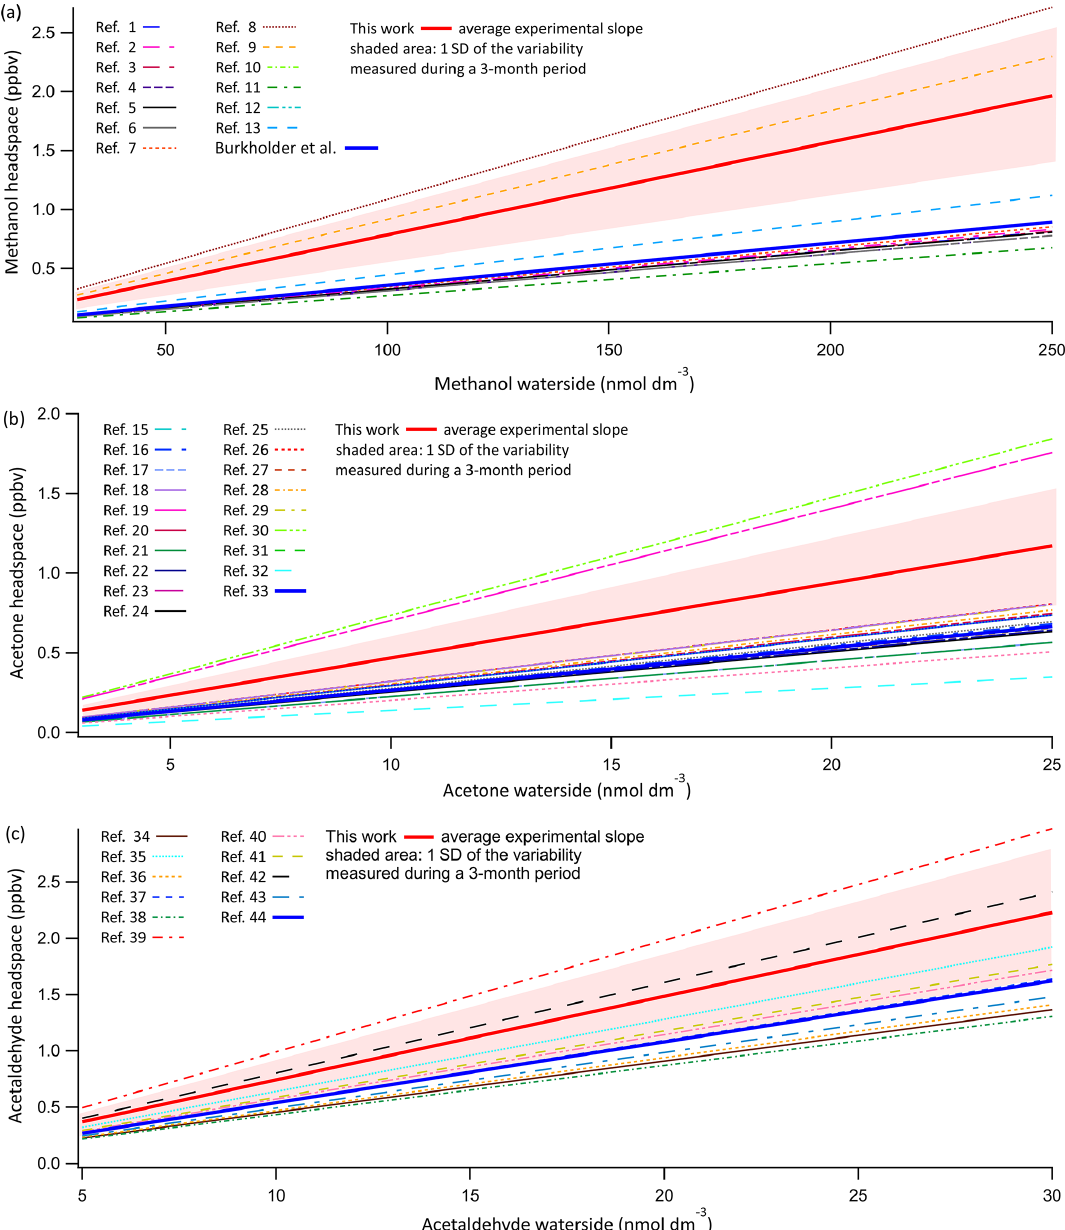
Figure 4. Evasion calibrations of OVOCs. Displayed are the average experimentally determined slopes of 14 calibration curves of methanol (a) and acetone (b) and 11 calibration curves of acetaldehyde (c) . These calibrations suggest possibly lower solubility of these com- pounds compared to literature values. Shaded area indicates 1 σ standard deviation of the variance in the slope during this 3-month period. Average experimentally determined calibration slopes for methanol, acetone, and acetaldehyde were 0 . 00786 ± 0 . 00115, 0 . 0469 ± 0 . 0145, and 0 . 0743 ± 0 . 0190ppbvnmol − 1 dm 3 . Plotted along this are the predicted slopes using all experimentally determined solubilities as listed in Sander (2015). The recommended solubility by Burkholder et al. (2015) is plotted as a solid thick line in dark blue. The key to the figure is listed in a table in the Supplement, listing the in-figure reference followed by the dimensionless water-over-air Henry solubility in Milli-Q water at 20 ◦ C and the predicted slope using the listed experimentally determined solubility. For full references of the cited solubilities, please refer to Sander